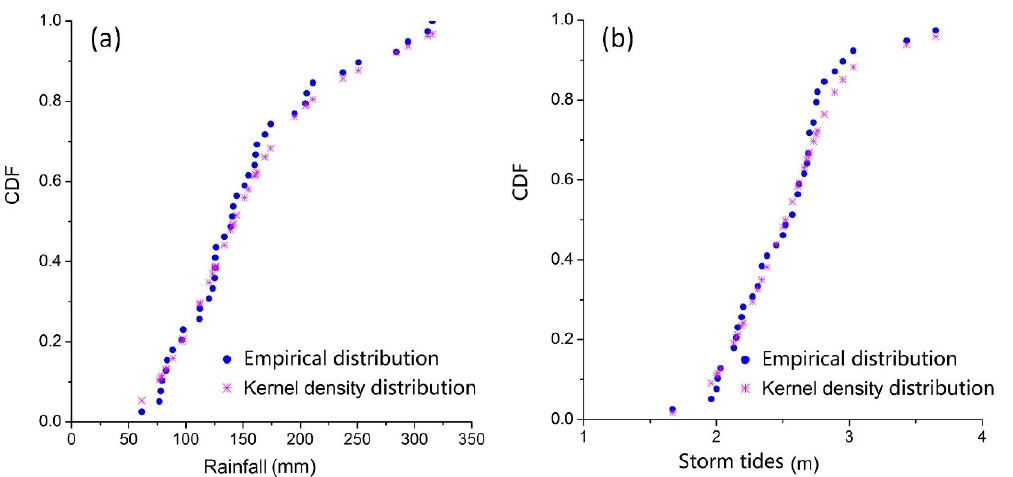
Figure 6. The empirical distribution and kernel density estimation distribution of ( a ) rainfall, ( b ) storm tides.